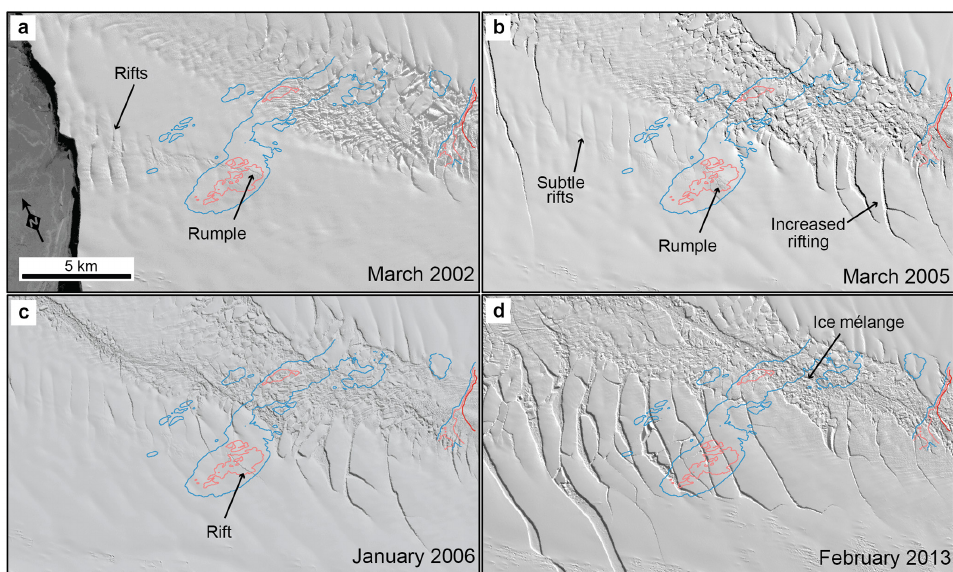
Figure 3. Time series of ASTER satellite images taken from the area of the submarine ridge. Lines indicate depth contours of 350m (dark red), 400m (light red) and 450m (blue). (a) Taken on 28 March 2002; note the ice rumple on top of the ridge. (b) Taken on 1 March 2005; note continued ice rumple and increased rifting in the east. (c) Taken on 18 January 2006; note the rift forming on top of the ridge. (d) Taken on 10 February 2013; note the absence of ice irregularities on top of the ridge, continuous intense rifting to its east and ice mélange to its